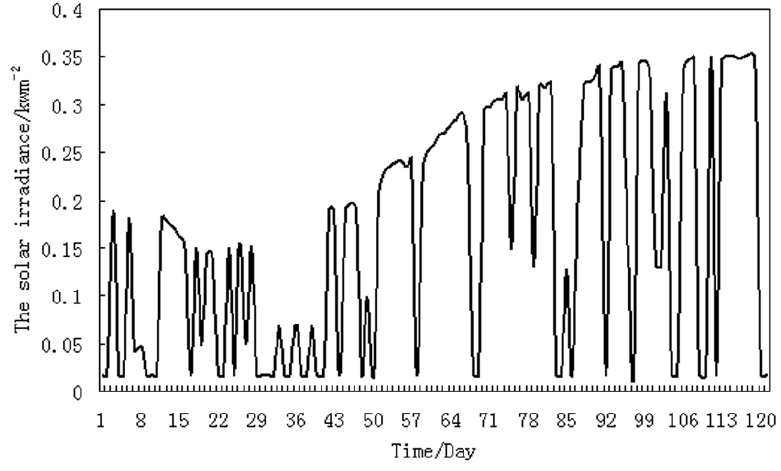
Figure 8. Amount of solar irradiance (kW/m 2 ) over the four month period (December–March).